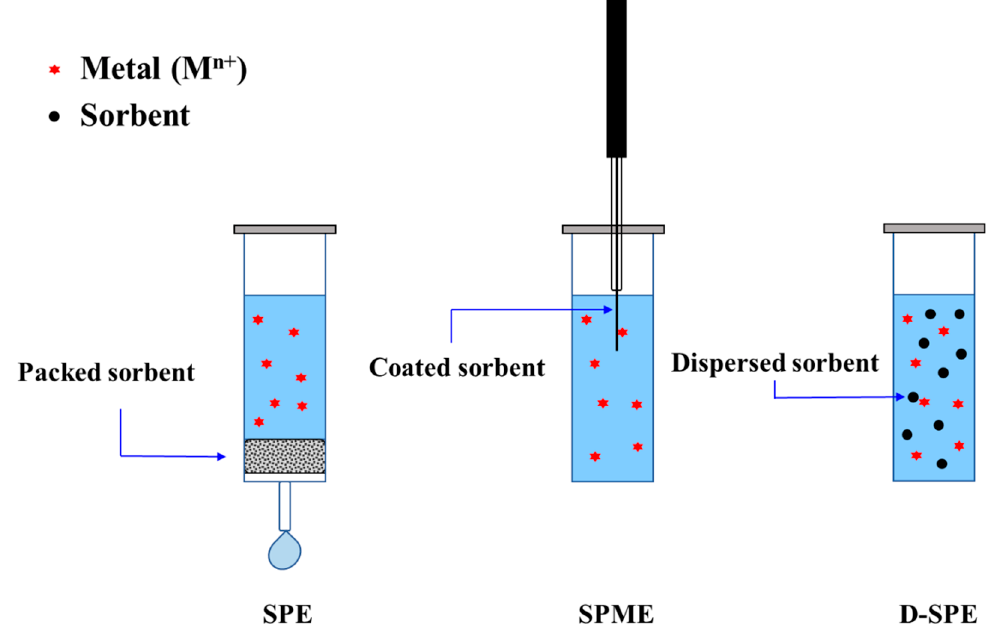
Figure 2. Schematic representation of solid-phase extraction (SPE), solid-phase microextraction (SPME, direct immersion only), and dispersive solid-phase extraction (D-SPE).